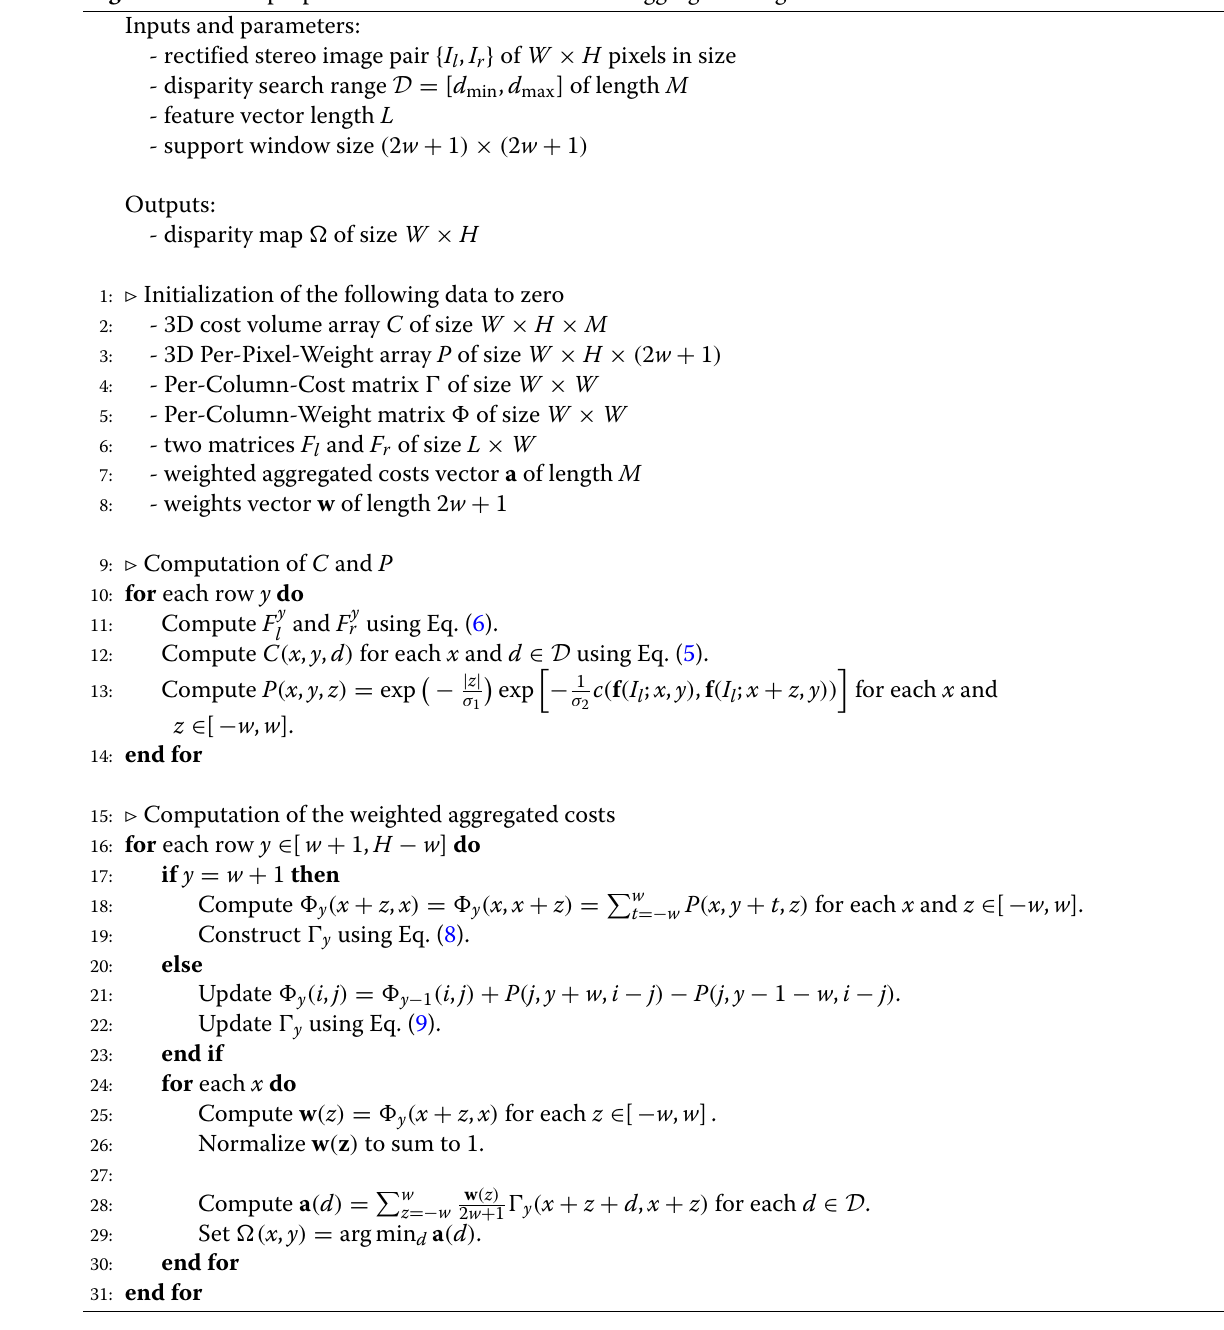
Algorithm 1 The proposed feature-vector-based cost aggregation